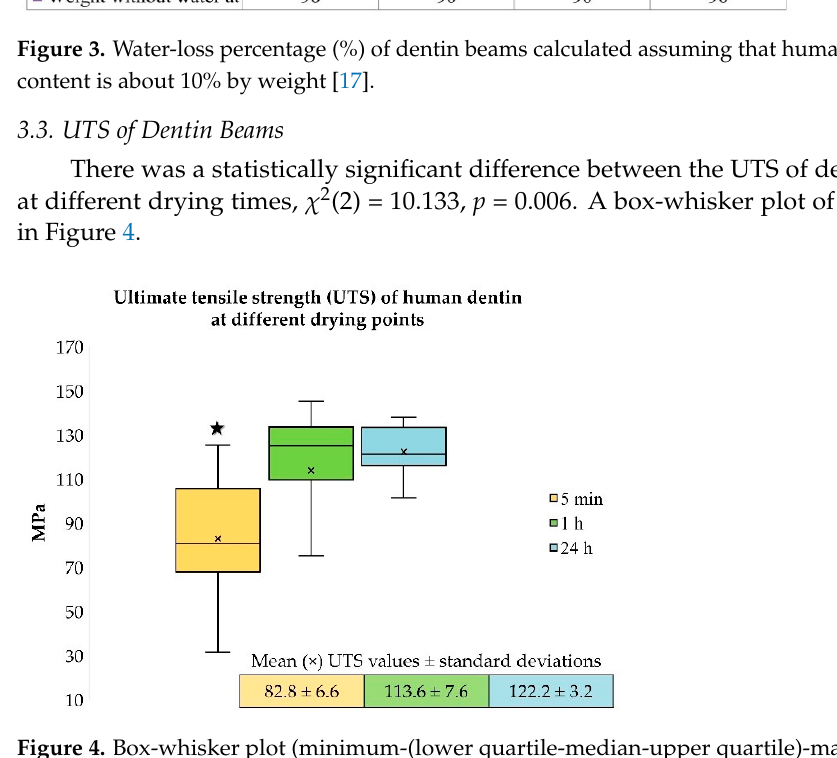
Figure 4. Box-whisker plot (minimum-(lower quartile-median-upper quartile)-maximum) of UTS values of human dentin at 5 min, 1 h, and 24 h after blot drying. The statistically significant difference between different time groups has been presented with the “ (cid:70) ” symbol. The table in the figure shows the mean ( × ) UTS values of different groups with their standard deviations. An overall increase in the mean UTS can be observed with increased drying time.